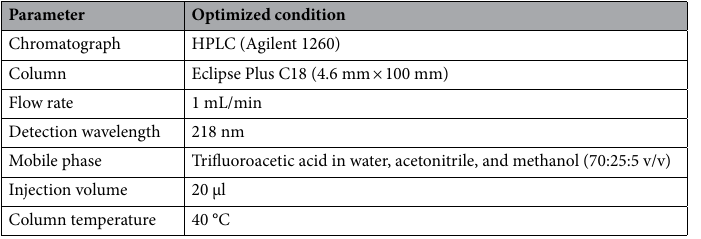
Table 1. Optimized chromatographic conditions.